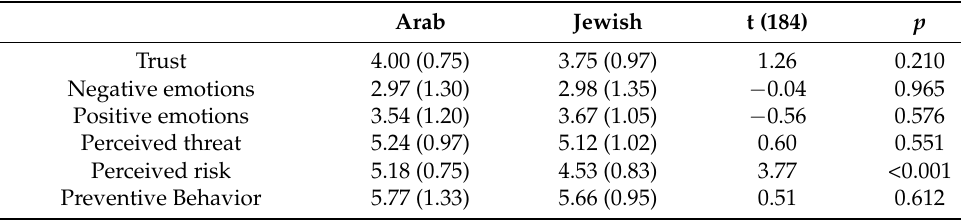
Table A3. t -tests for the study variables by ethnicity ( N = 186).